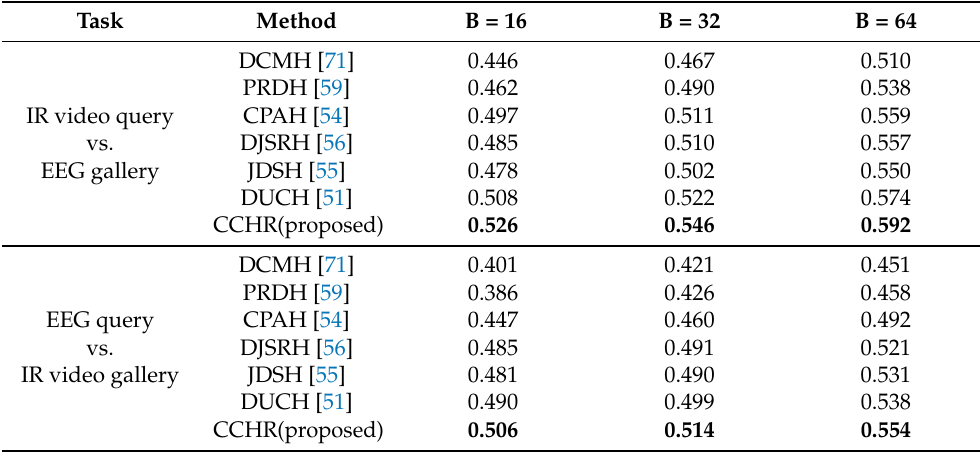
Table 3. MAP@1000 comparison with different state-of-the-art cross-modal hashing retrieval methods on the dataset S 3 VE